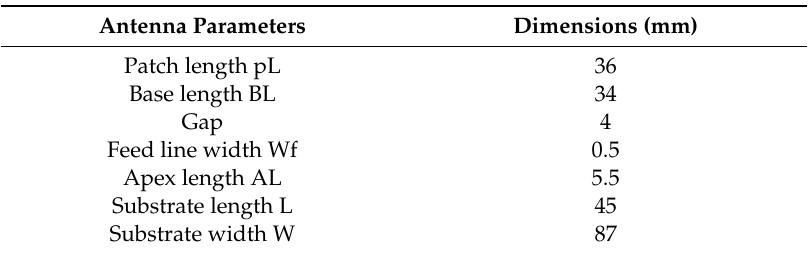
Figure 2. Design of the geometry of antenna A and B with same substrate RT/Duroid 5880LZ material and different thickness. Table 3. Antenna A